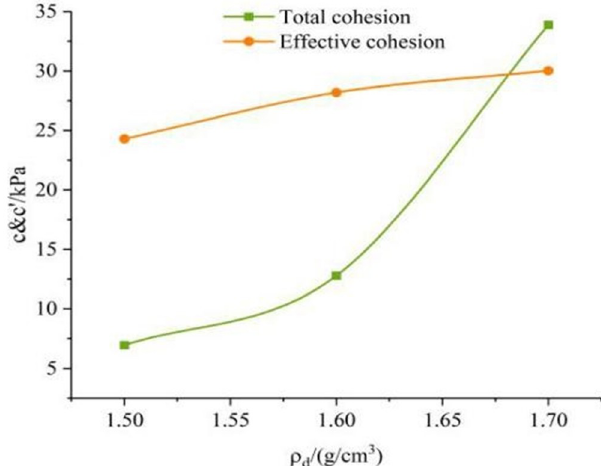
Fig 12. The curve of shear strength index φ with dry